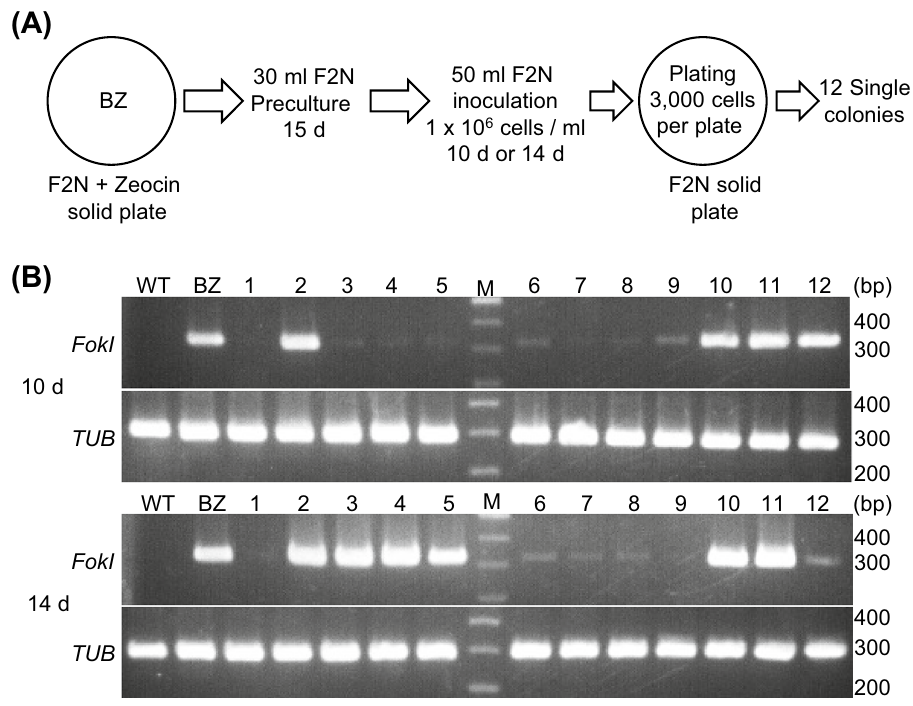
Figure 4. Verification of the efficient clearance method for all-in-one PtTALEN-ARS plasmids from Nannochloropsis oceanica cells using solid F2N plates. ( A ) Workflow of the clearance of all-in-one PtTALEN- ARS plasmids from host cells using culture spreading onto solid F2N plates. All-in-one PtTALEN-ARS plasmids could be removed earlier than the procedure shown in the Fig. 2A workflow. ( B ) Verification of the clearance of all-in-one PtTALEN-ARS plasmids from host cells using culture spreading onto solid F2N plates by PCR. The 12 colonies that emerged in F2N without zeocin plates were collected, cultured with 2 mL F2N liquid medium, and used for the PCR analysis. WT: total DNAs extracted from wild-type cells; BZ: total DNAs extracted from individual colonies of all-in-one NoNR PtTALEN-ARS plasmids; 1–12: total DNAs extracted from strains collected from F2N solid plates; FokI : FokI PCR amplicons; TUB : tubulin-beta PCR amplicons; M: DNA ladder marker. 10 d and 14 d indicate the duration (10 or 14 days) of liquid